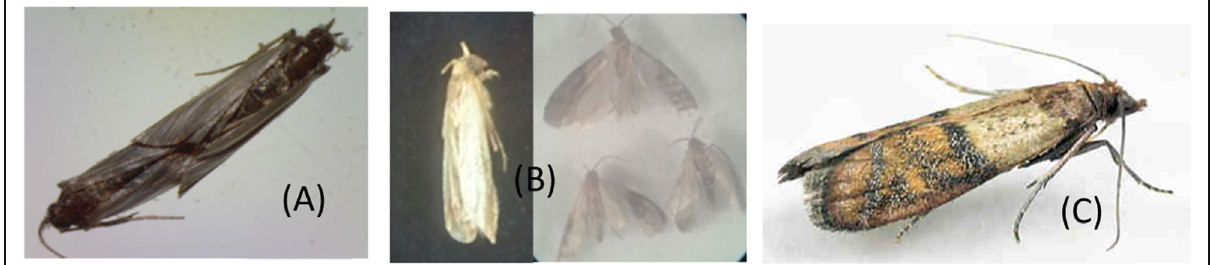
Fig. 1 Failure of Plodia interpunctella moths to be separated after copulation ( a ). Note the undersized moths ( b ) and the healthy one ( c ) (magnification ca. ×